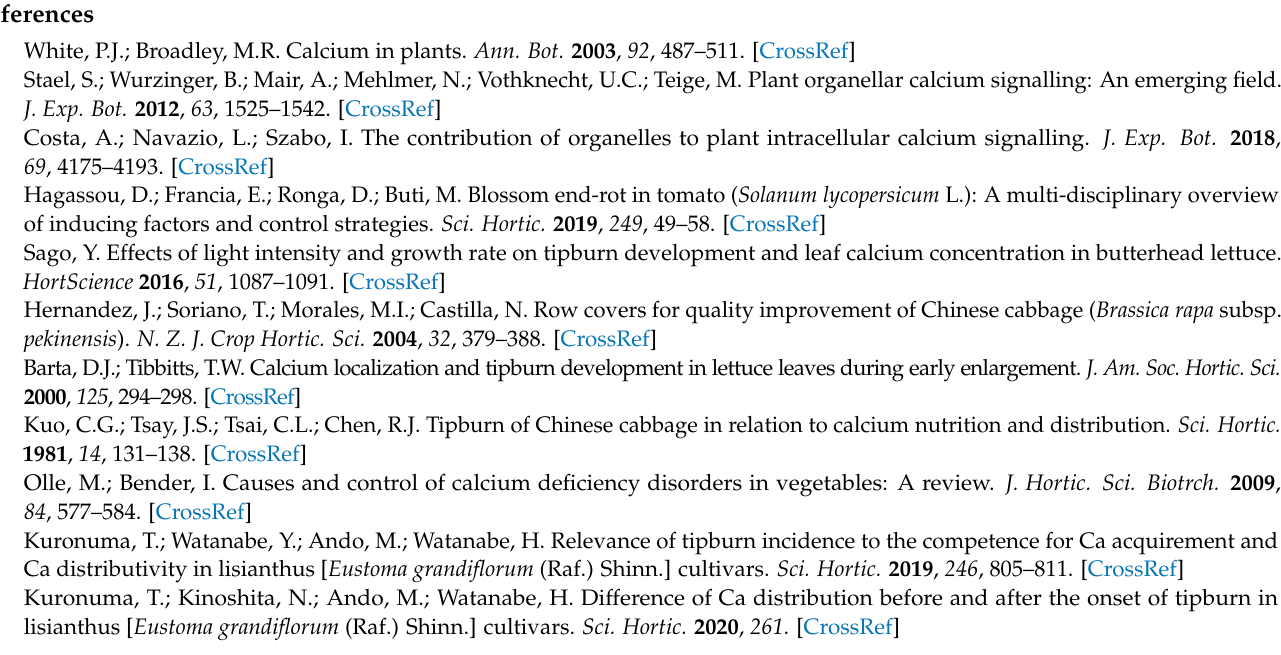
Figure S1: Gene Ontology (GO) annotation of the assembled two lisianthus